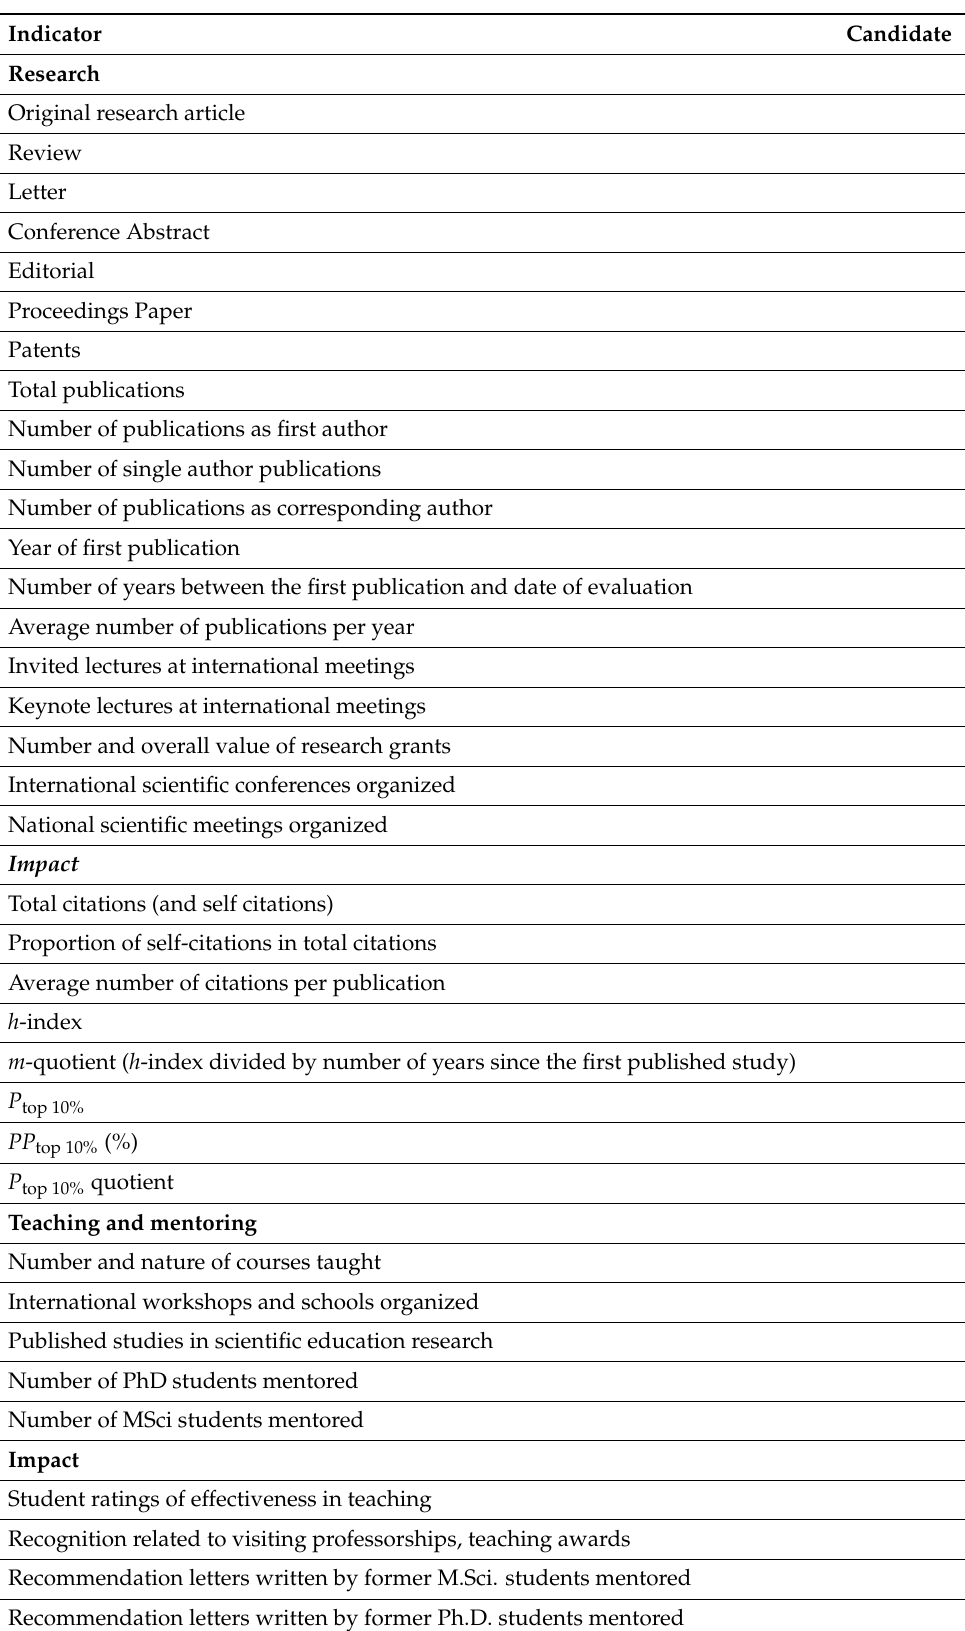
Table 1. Framework for assessing candidates for tenure and promotion based on achievements in research, teaching and mentoring, and societal service. Adapted from reference